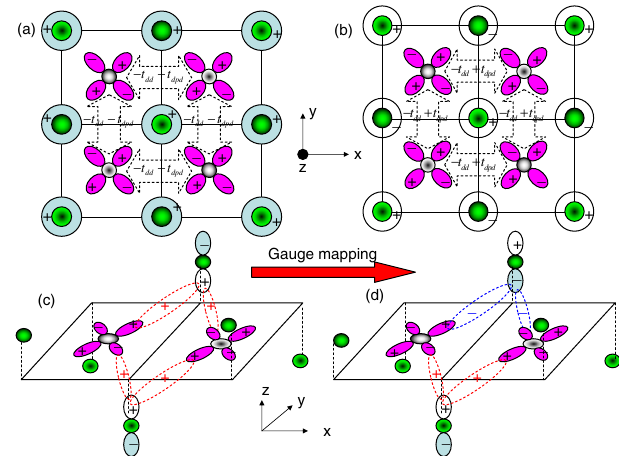
FIG. 2. The nearest-neighbor hopping parameters for intra- d xy orbitals are shown in (a) and (b). t is the amplitude of the direct dd orbitals, while t is the amplitude of the indirect hopping of d xy dpd hopping through p orbitals of As = Se atoms. The reason for the z between (a) and (b) is that the p orbitals in sign change in t dpd z the top layer and the bottom layer form occupied bonding states in (a) and empty antibonding states in (b). The difference is orbitals in (a) and (b). (c) illustrated by the filled and empty p z and (d) show the local p (cid:1) d s -wave pairing pattern and a gauge transformation between them, which is defined by adding a orbitals on the top As(Se) layer but not to minus sign to all p z those on the bottom